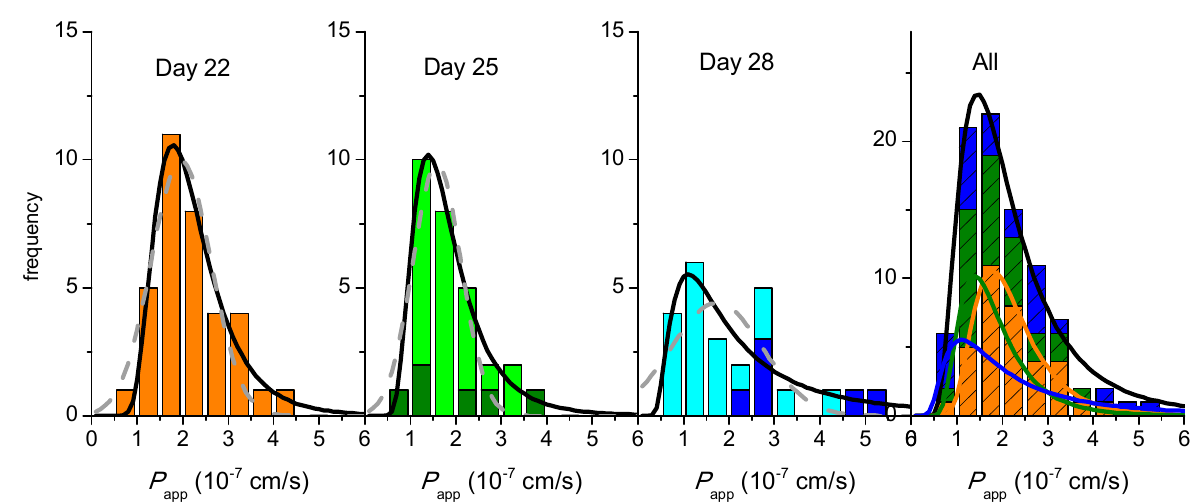
Figure 3. Dependence of LY P app (single sampling at 60 min) on the day post-seeding and on the re-use of the monolayer for additional permeability assays after incubation with culture media for two full days. The left plots show the distribution of P app values obtained on the different days after cell seeding; dark colors represent results for single use and light colors for re-used cell monolayers; the lines are the best fit of a Normal distribution (grey dashed) or a LogNormal distribution (black continuous). The plot on the right shows the cumulative results at all days and conditions; the lines are the best fit of a LogNormal distribution for data from each day (colored) and collectively for all days (black), with the parameters given in the Supplementary Material—Table S2.2.